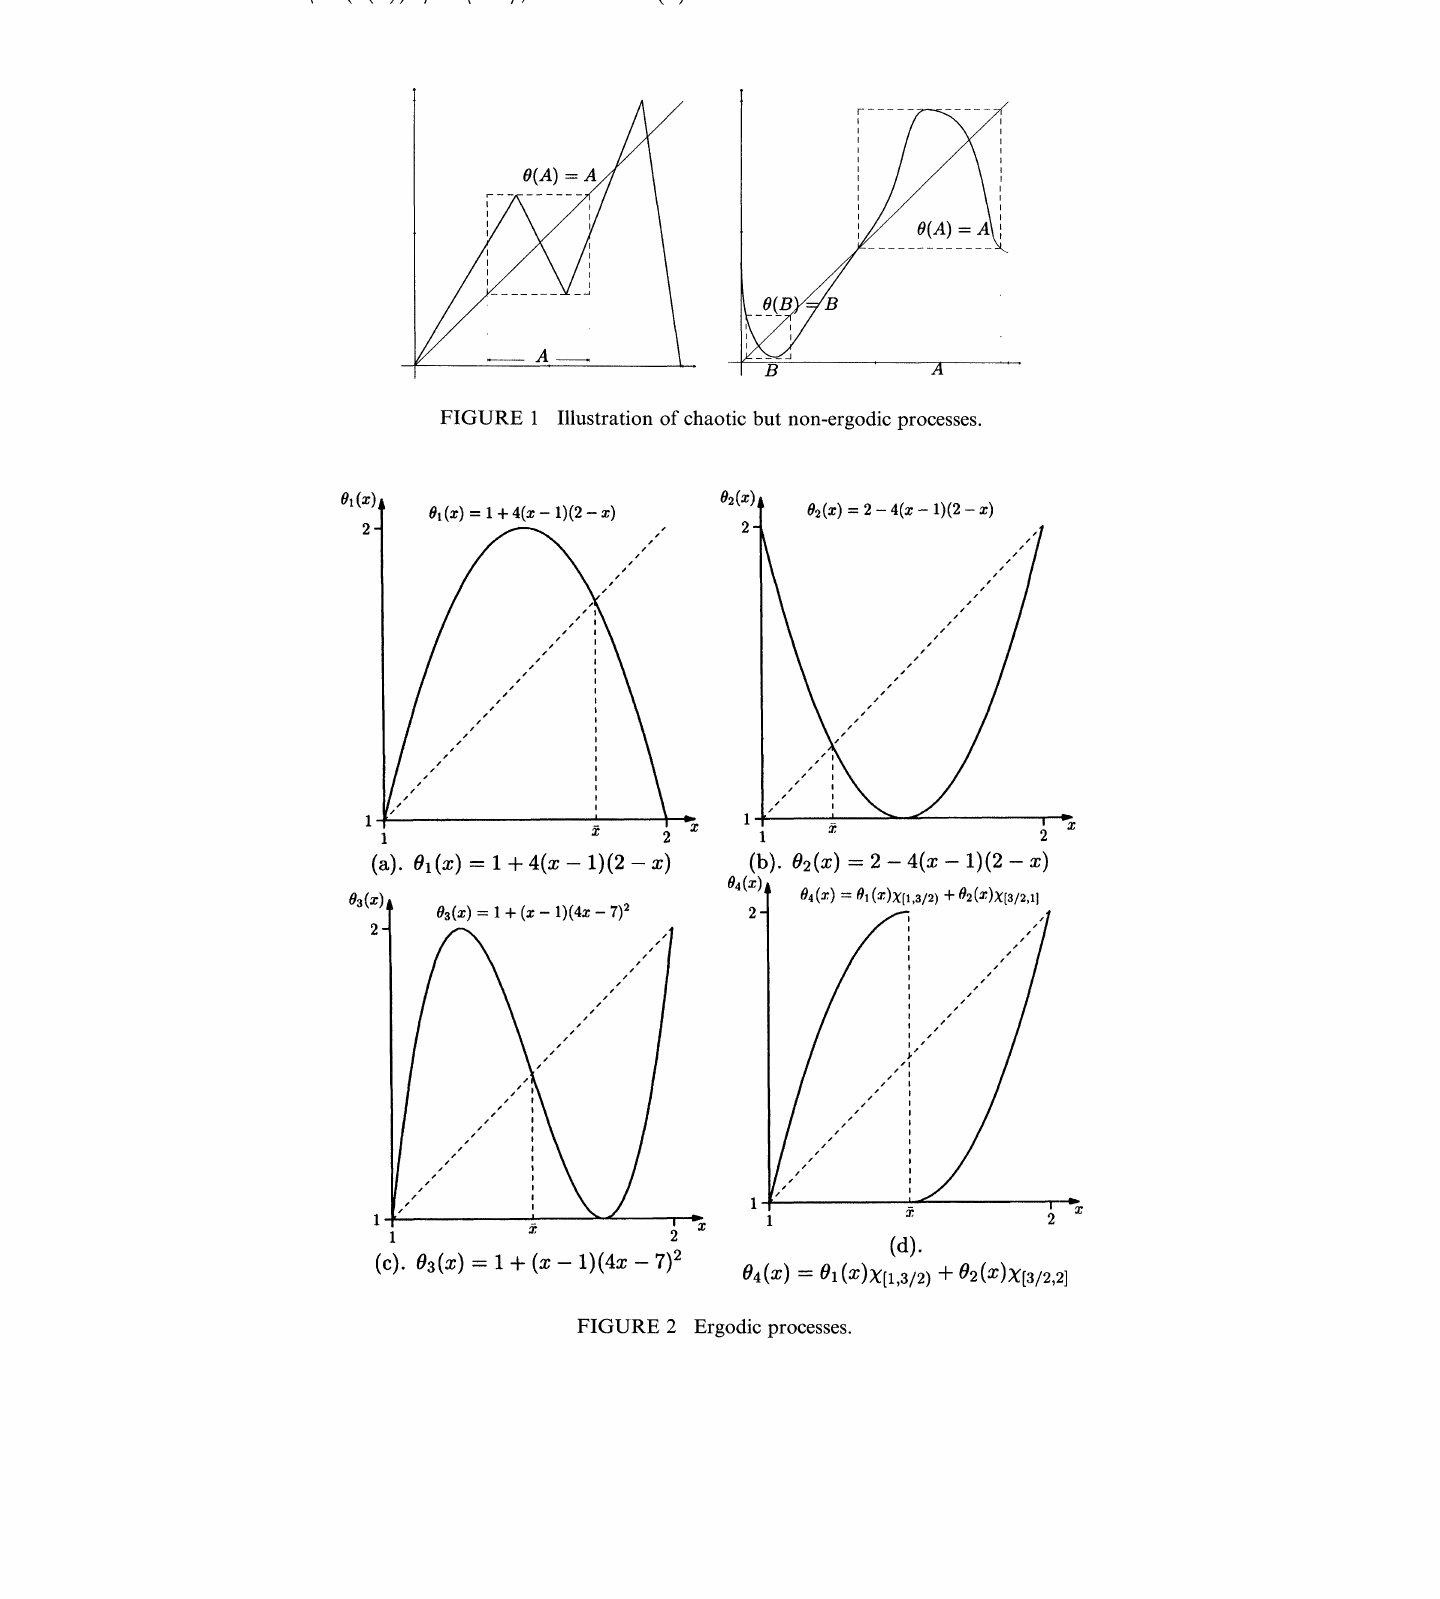
FIGURE Illustration of chaotic but non-ergodic processes.